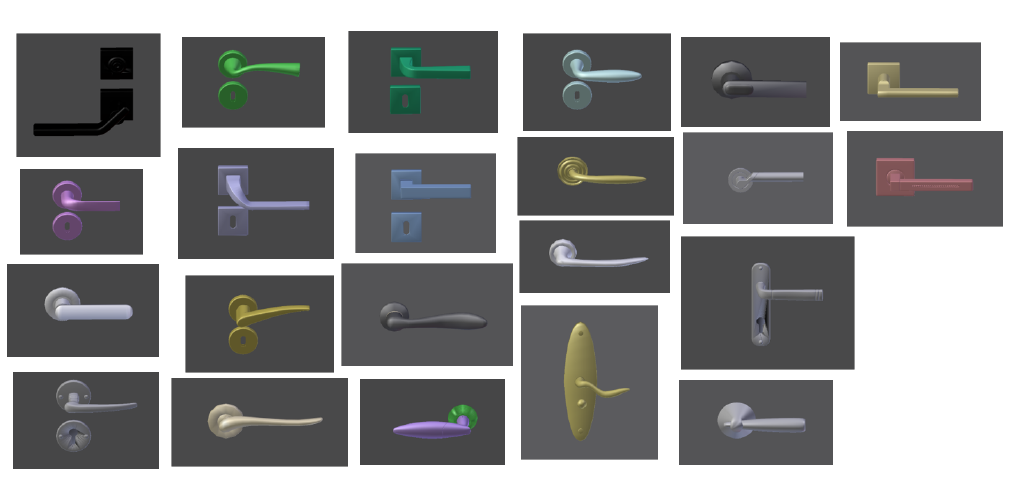
Figure 8. Data base of door handle models for which the approach has been successfully tested.